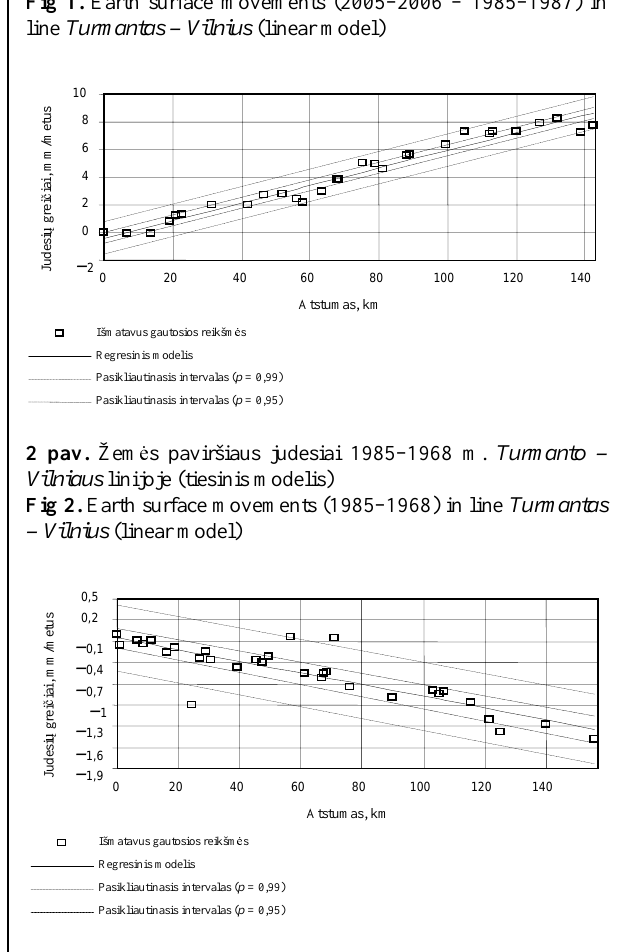
Jonavos linijoje (tiesinis modelis) Fig 6. Earth surface movements (1998–1970) in line Vilnius – Jonava (linear